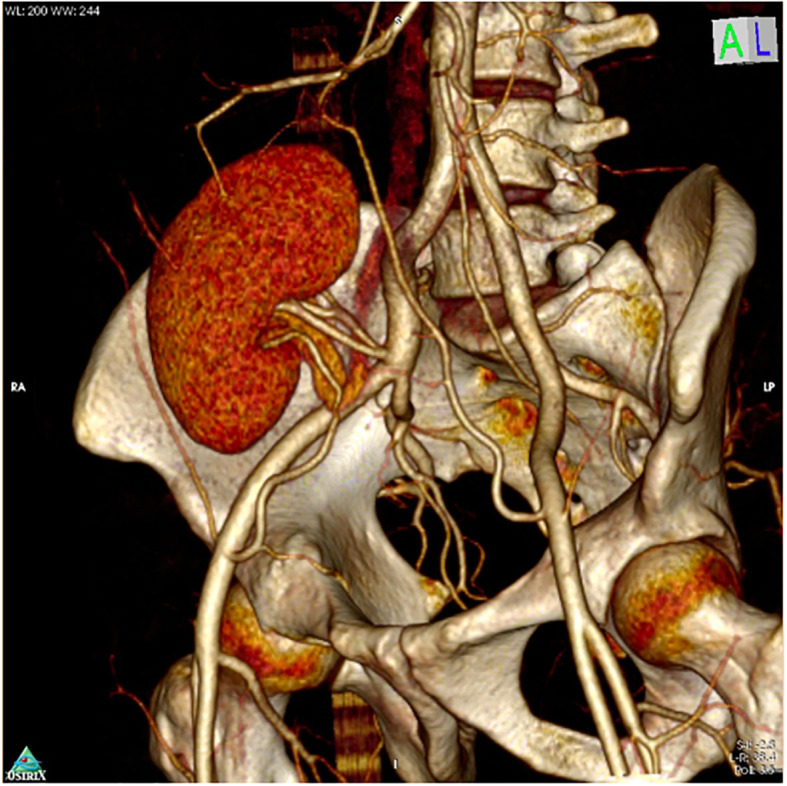
CT angiogram after 3 months after RAKT showing patent Pantaloon and accessory lower pole vessel anastomosis.